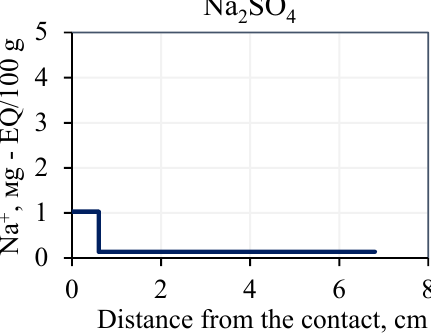
Figure 13. Contents of salt ions along frozen hydrate-bearing sand samples after 4 h of interaction with 0.1 N CaCl 2 , KCl and NaCl solutions at − 6.5 ◦ C and 0.1 MPa. Salt ions penetrated the farthest (5 cm from the contact) into the sample that interacted with the MgCl 2 solution. The respective values for other salts were 4.6 cm for NaCl, 2.8 cm for CaCl 2 , 2 cm for KCl, and only ~0.6 cm for Na 2 SO 4 . The salts arrange in the same series Na 2 SO 4 –KCl–CaCl 2 –NaCl–MgCl 2 according to